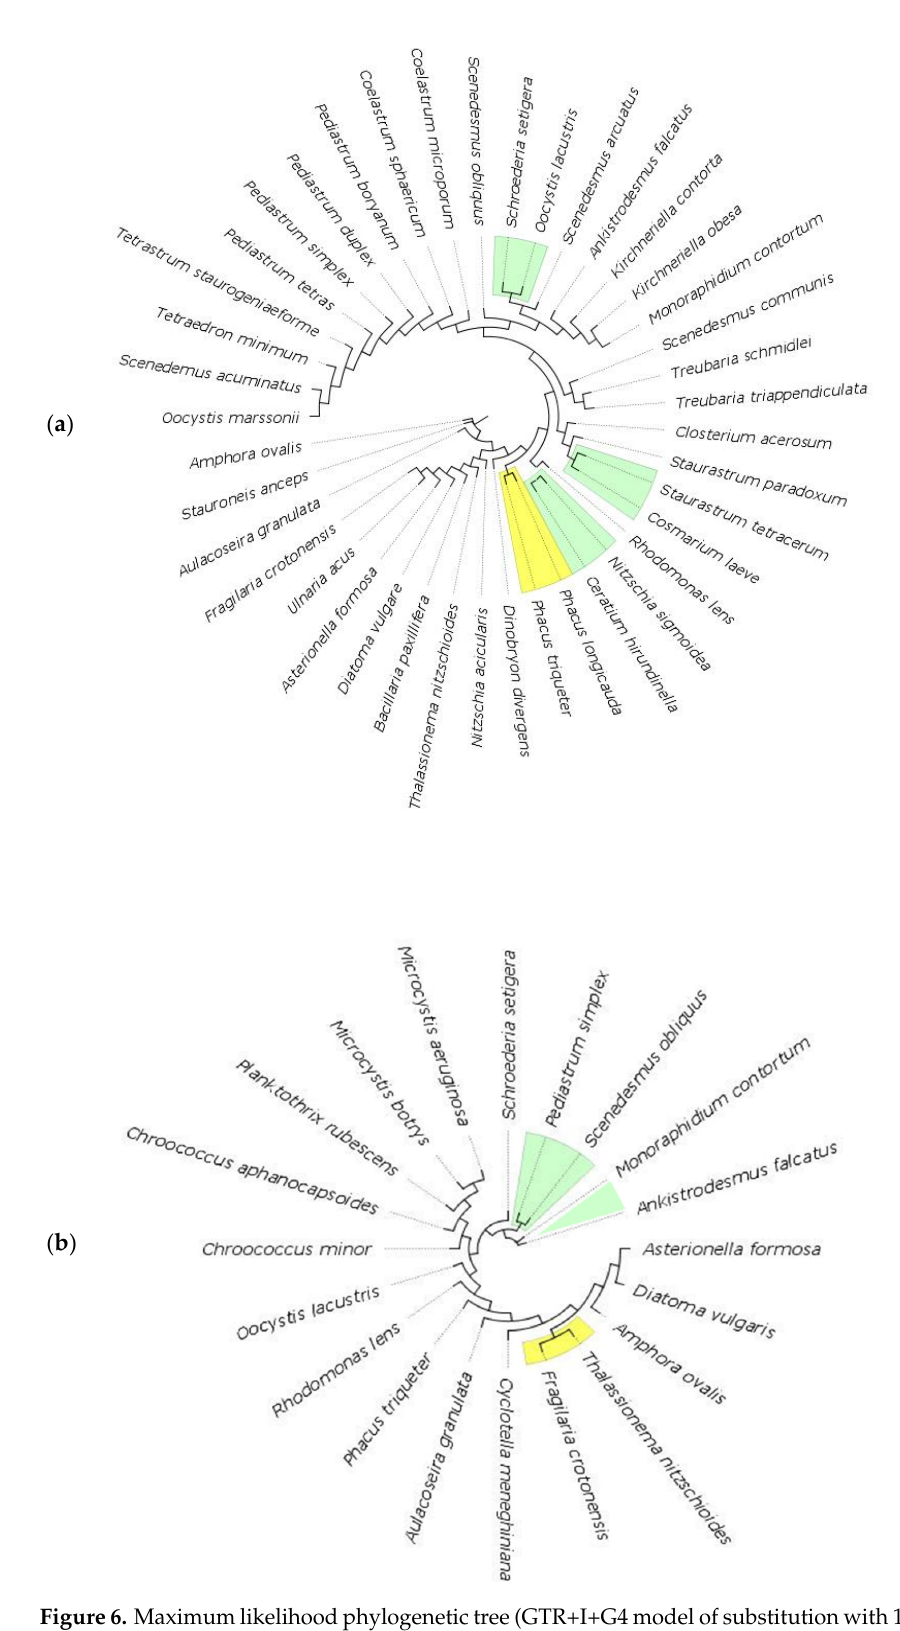
Figure 6. Maximum likelihood phylogenetic tree (GTR+I+G4 model of substitution with 100 bootstrap replicates) of lake species for 18S markers ( a ) and 16S marker ( b ). Colored branches indicate species that cluster together under bPTP analysis, with green representing Bayesian support (BS) values of 0.3 or below, yellow for BS 0.3–0.5, red for BS